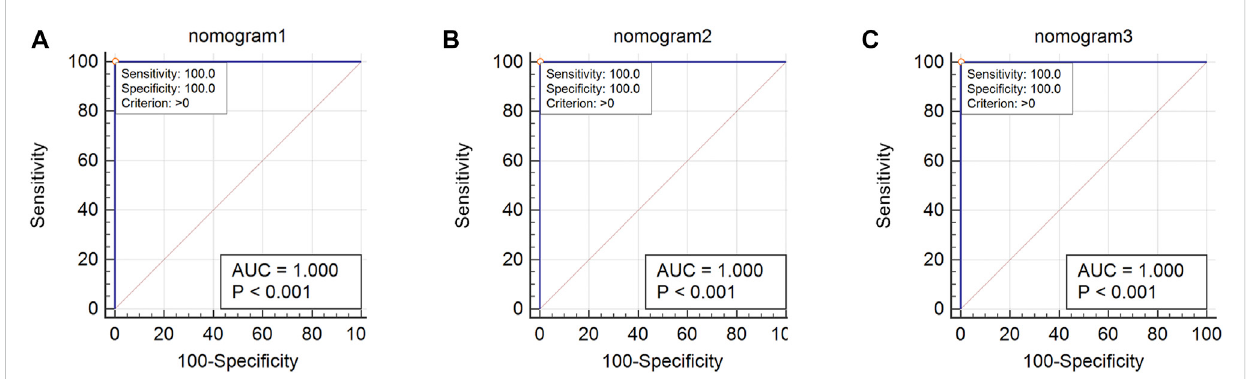
FIGURE 12 ROC curveof nomogram. (A) :Nomogram ROC ofthetraining cohort; (B) Nomogram ROC oftheinternalvalidation cohort; (C) Nomogram ROC of the external validation cohort.